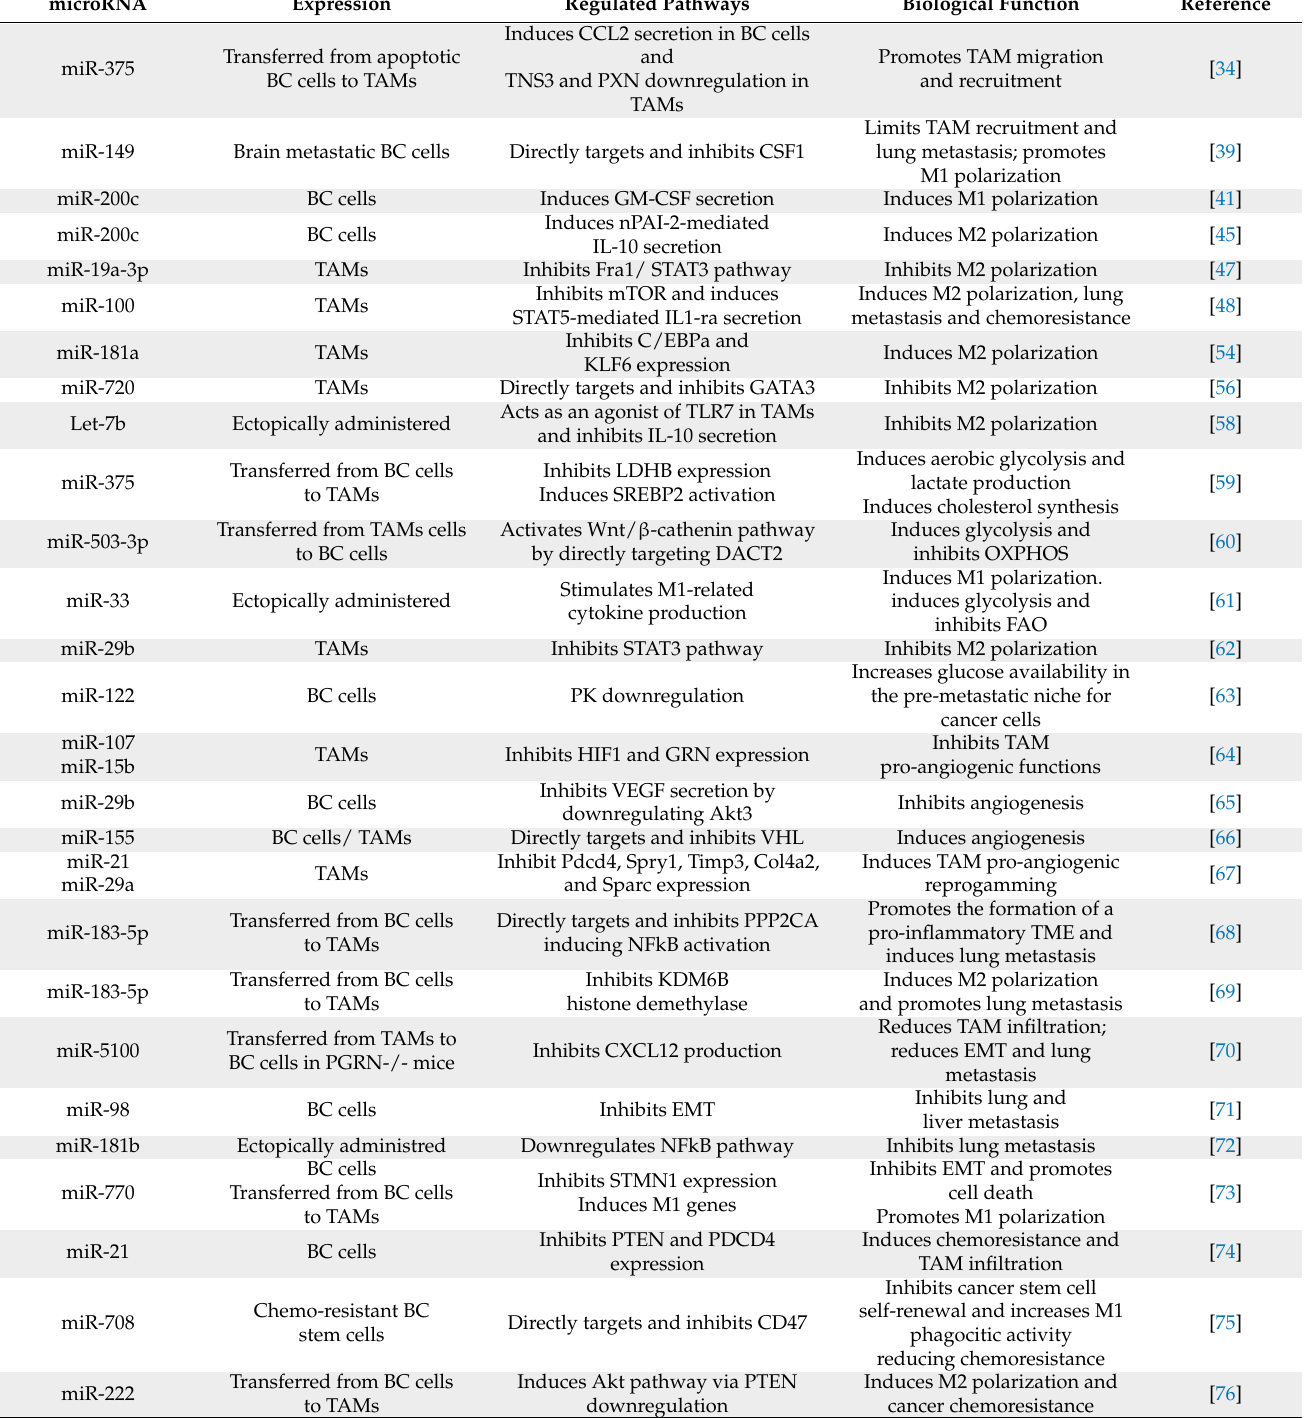
Table 1. miRNAs involved in BC cells-TAM crosstalk during BC